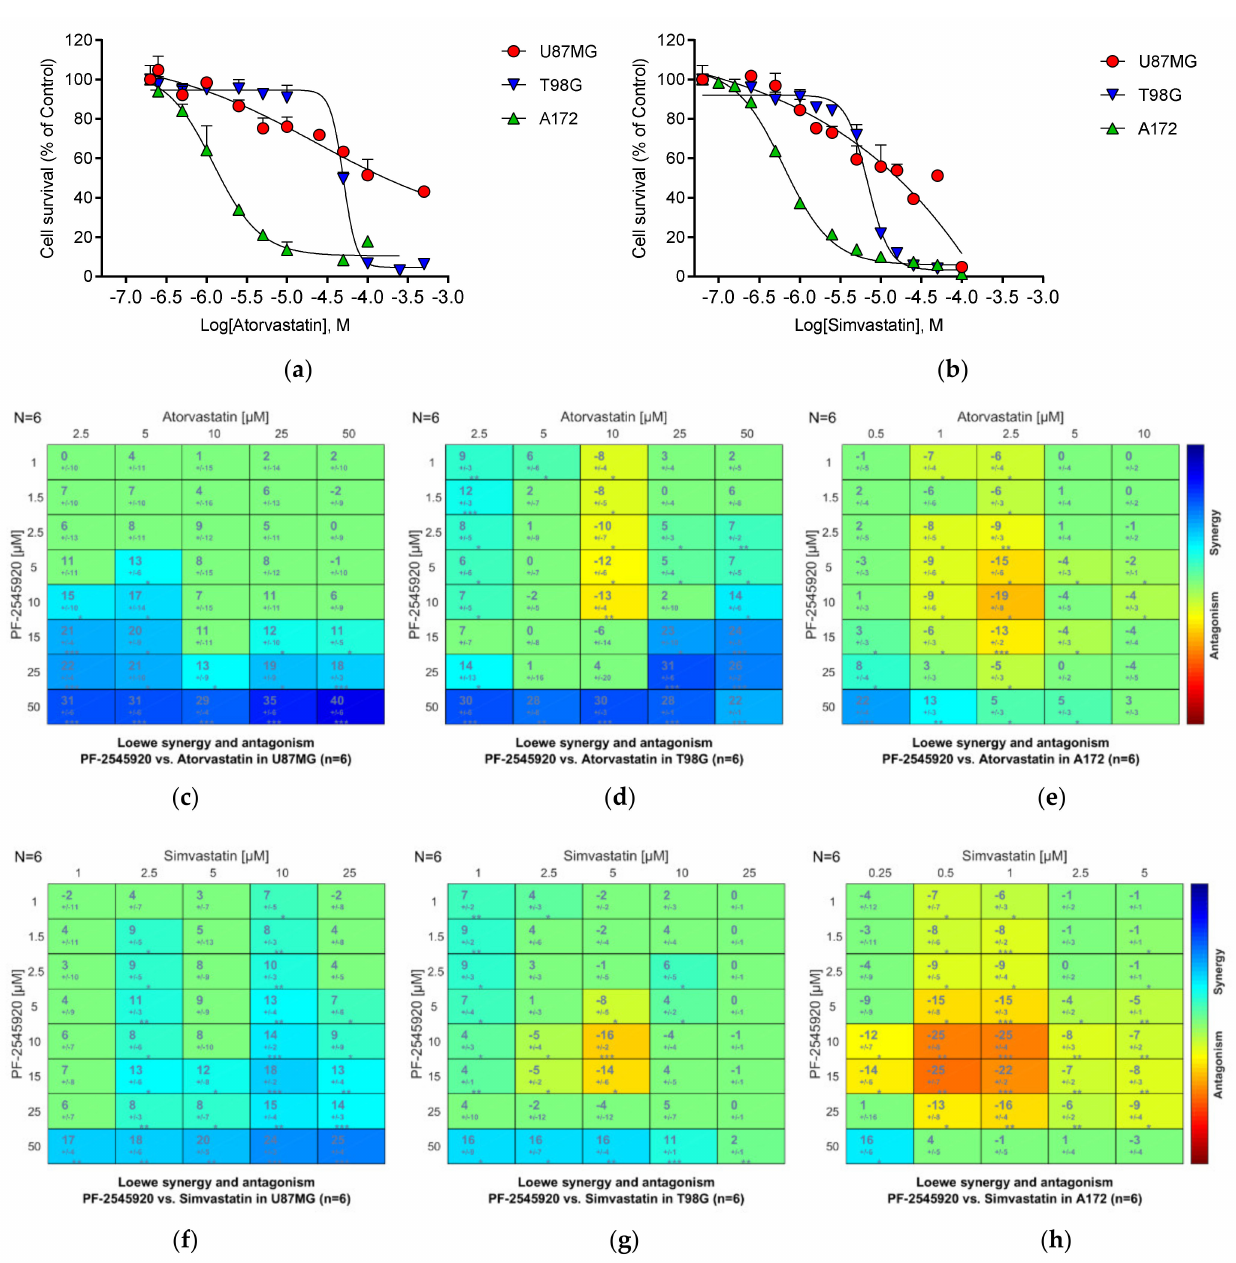
Figure 8. Anti-proliferative effects of HMGCoA reductase inhibitors on U87MG, A172 and T98G cells. ( a ) Atorvastatin; ( b ) Simvastatin. Data are presented as the mean ± standard error of the mean (SEM) ( n = 3–6). Panels ( c – e ) show Loewe synergy plots for the combination of Atorvastatin and PF-2545920 in U87MG, T98G, and A172 glioblastoma cells, respectively. Synergy (in blue) was observed in U87MG and T98G cells at higher Mardepodect concentrations (with a maximal synergy score of 40), but signs of antagonism (in orange) were seen in A172 cells (synergy score of − 25). Panels ( f – h ) show Loewe synergy plots for the combination of Simvastatin and PF-2545920 in U87MG, T98G, and A172 glioblastoma cells, respectively. Again, some synergy was observed in U87MG and T98G cells, with scores ranging from 16 to 25, with the combinations showing definite antagonism in A172 cells (with a score of − 25). Note: asterisks indicate the significance of synergy scores obtained following a one-sample t -test (* p < 0.05; ** p < 0.001; *** p <